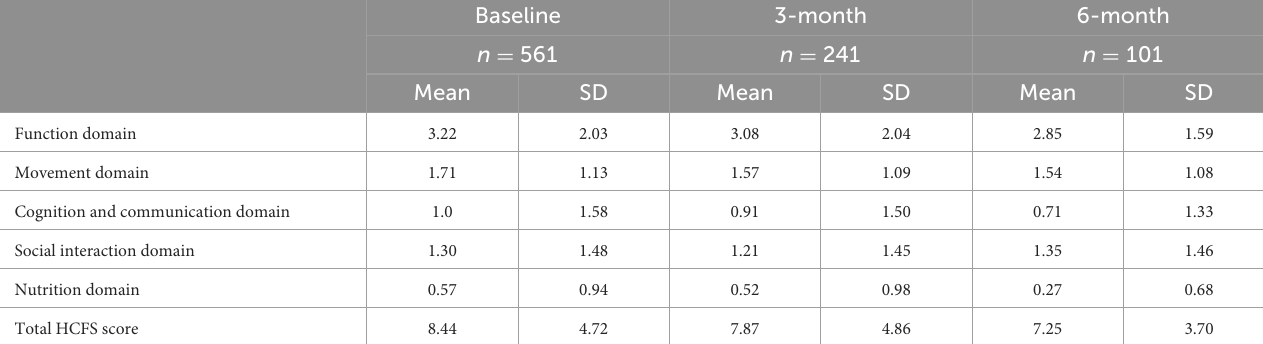
TABLE 4 Home care frailty scale (HCFS) scores at baseline, 3-month, and 6-month time points by